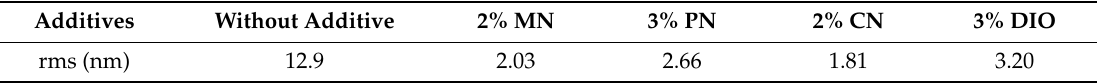
Table 4. Root mean square (rms) values of BHJ films treated with various solvent additives. Additives Without